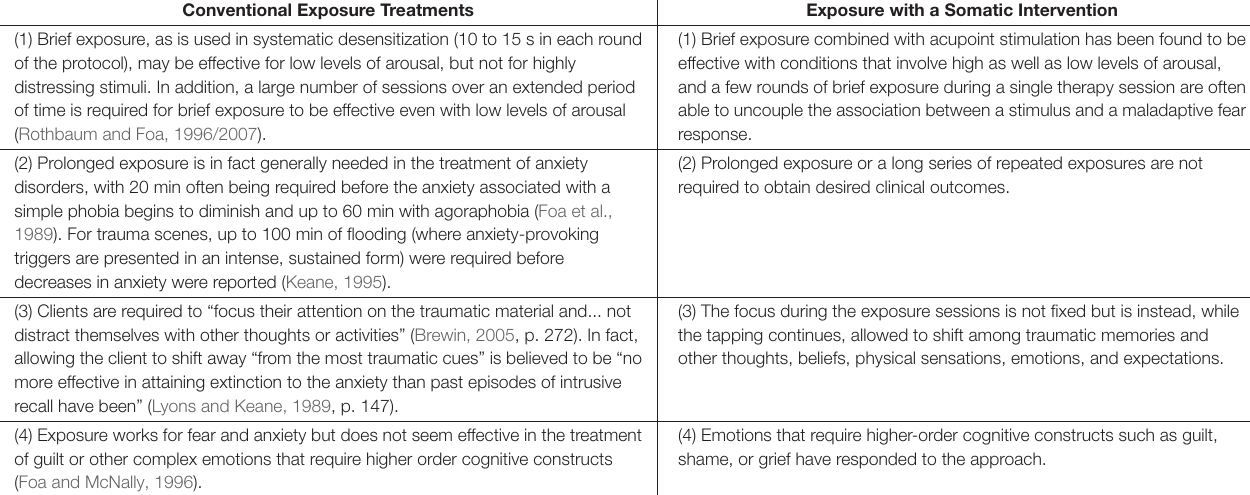
TABLE 1 | Two contrasting approaches to exposure. Conventional Exposure Treatments Exposure with a Somatic